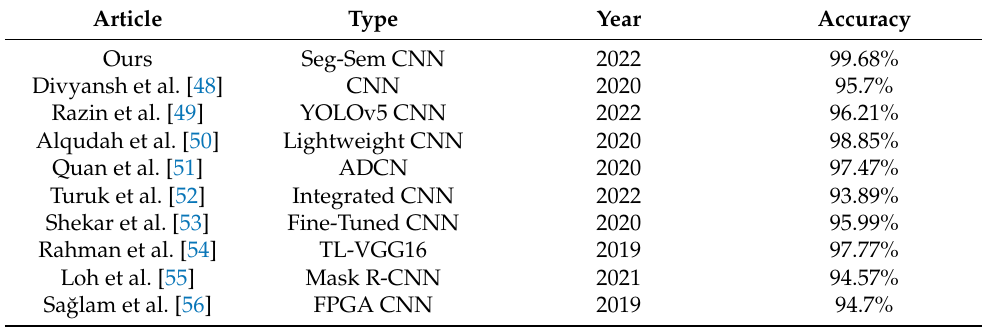
Table 1. Comparison table with other